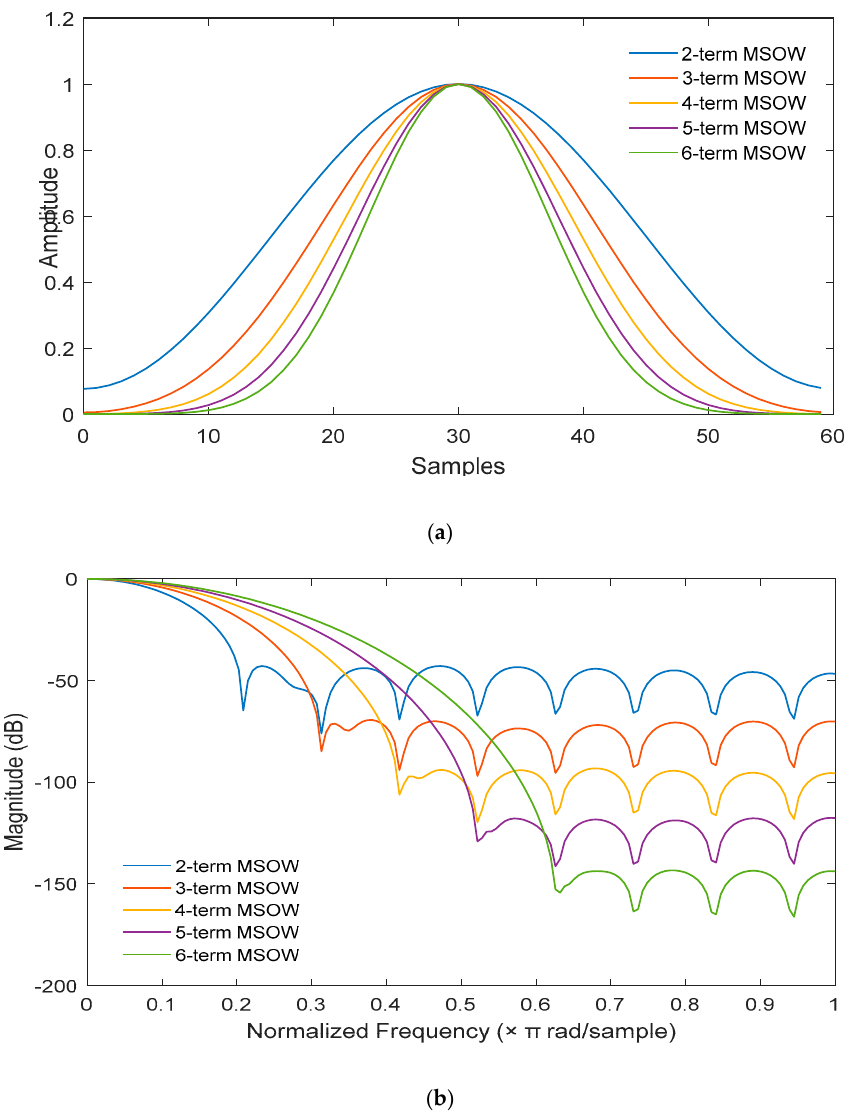
Figure 1. Characteristic of the minimum side-lobe optimization window. ( a ) Time domain characteristic and ( b ) frequency domain characteristic. Table 3. Performance of the minimum side-lobe optimization window.